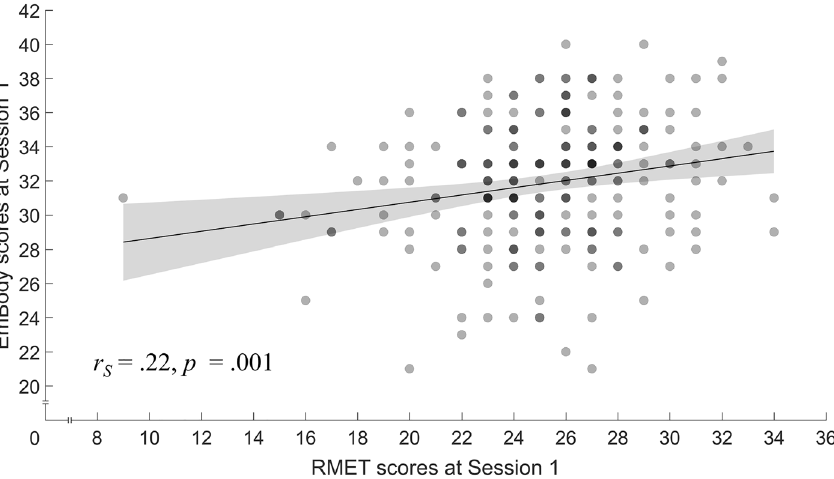
Figure 3. Relationship between sum scores in the EmBody and the RMET. The graph shows a line of best fit and the 95% confidence interval (shaded bands). Dots are semi-transparent so that locations with overlapping data points are